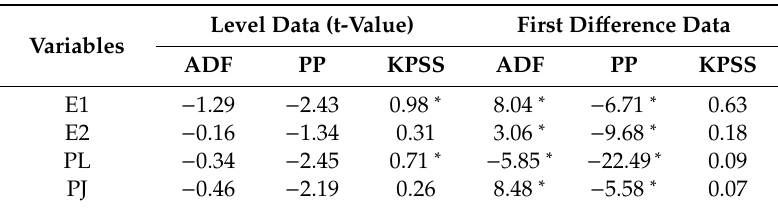
Table 2. Unit root